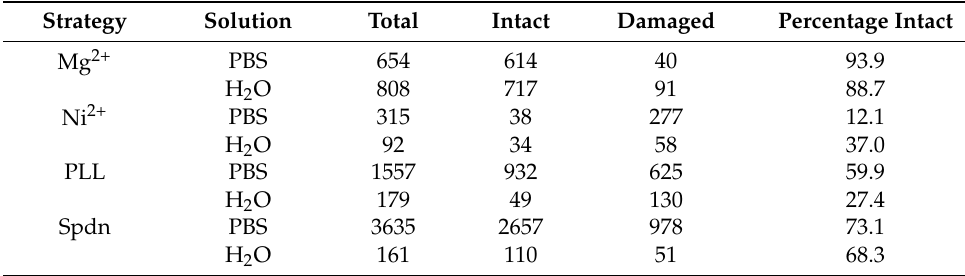
Figure 4. Surface coverage of adsorbed DOTs obtained for the different surface pretreatments and solution conditions. Values represent averages of five to twelve AFM images with the standard deviations as error bars. Table 1. Absolute numbers of total, intact, and damaged DOTs evaluated for each immobilization strategy with the resulting percentage of intact DOTs.